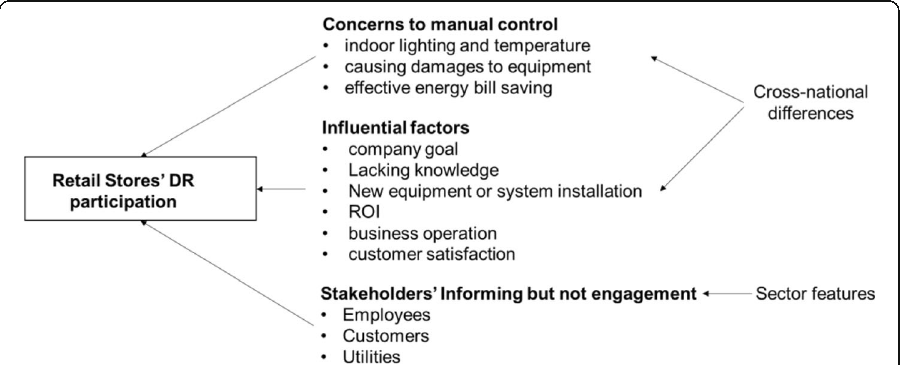
Fig. 13 Framework of retail stores ’ demand response